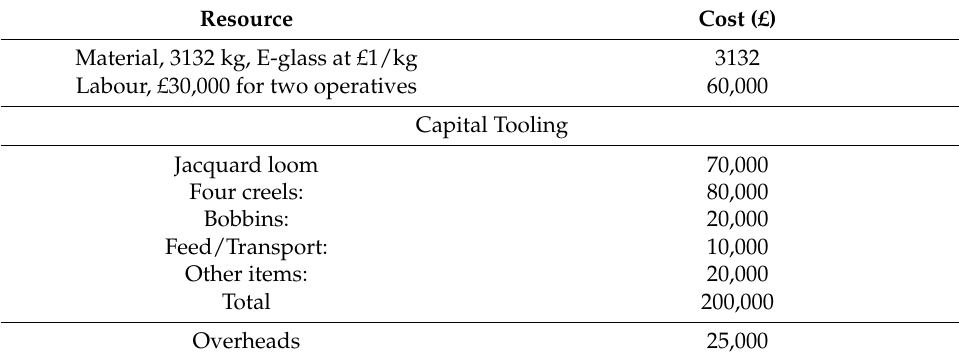
Table 6. 3D preform resource